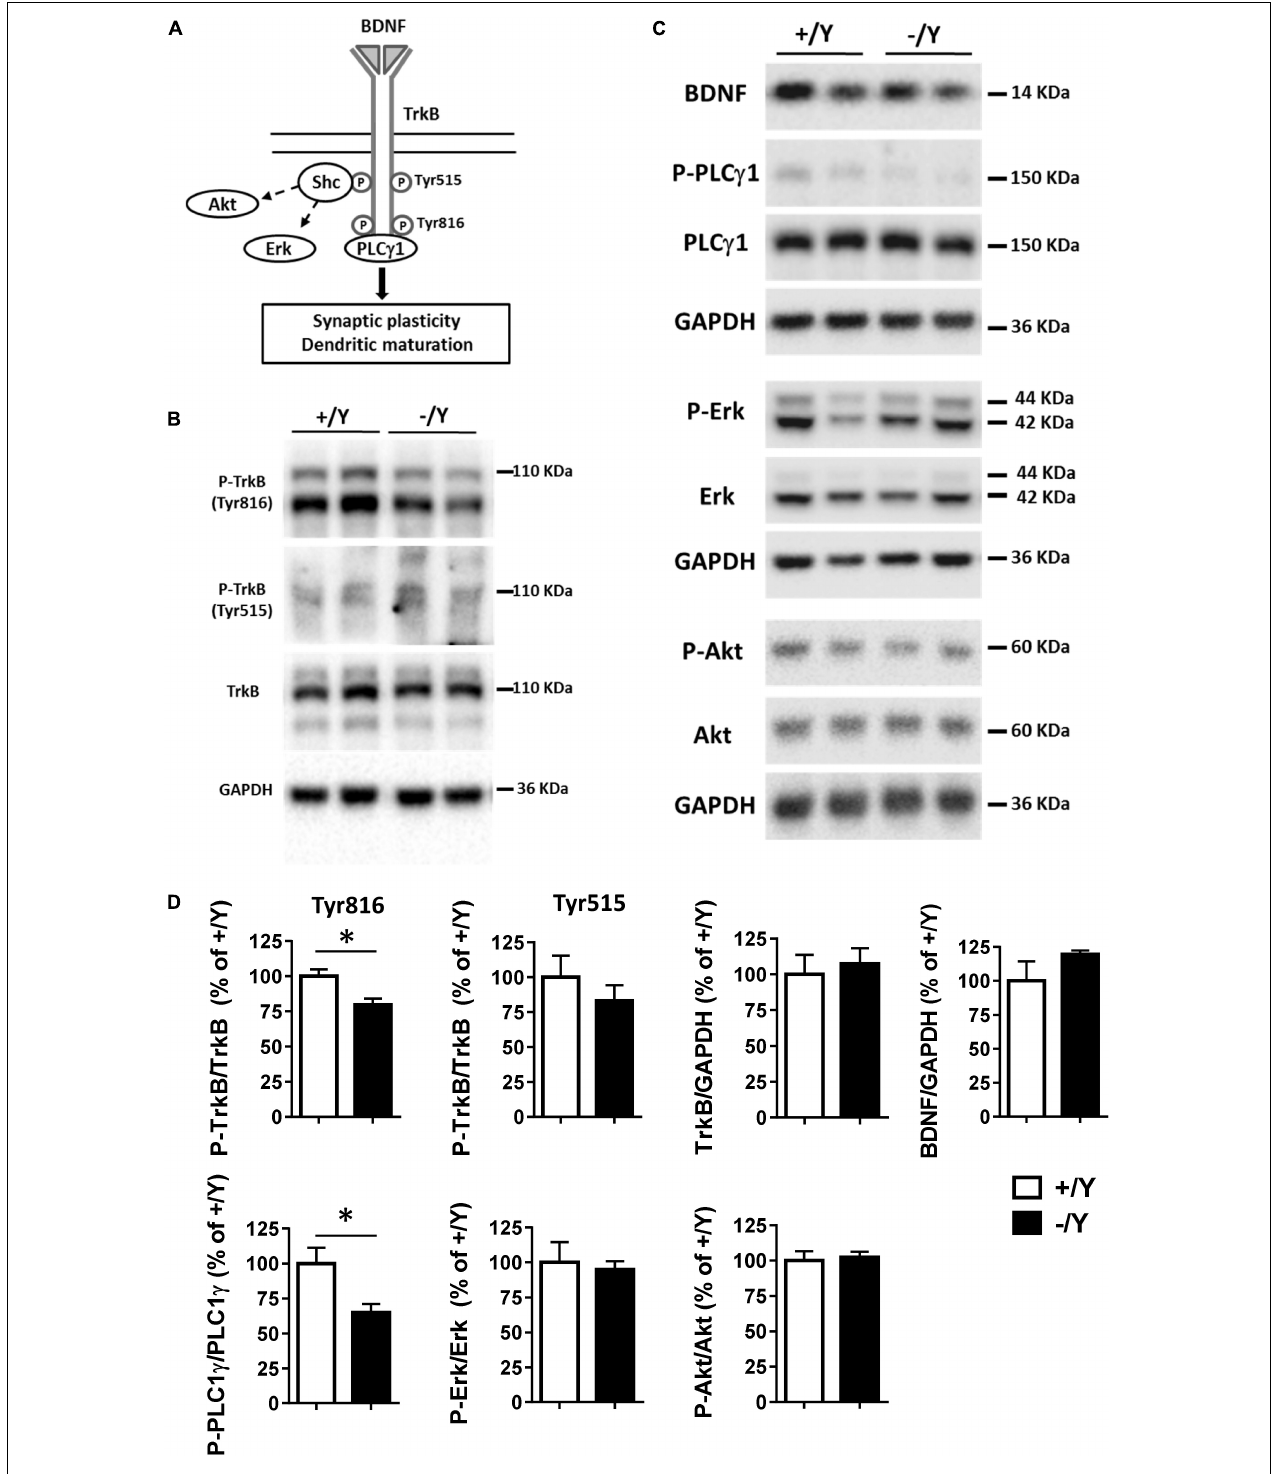
FIGURE 3 | TrkB signaling pathways in the perirhinal cortex of Cdkl5 +/Y and Cdkl5 − /Y mice. (A) Diagram of brain-derived neurotrophic factor (BDNF) and TrkB signaling pathways. BDNF binds to the extra cellular domain of TrkB forming homodimers to activate downstream intracellular signaling cascades, including Shc/Erk, Shc/Akt, and phospholipase C (PLC) γ 1 pathways. (B) Western blots examples of P-TrkB (Tyr816 and Tyr515) and TrkB in PRC homogenates of P50 Cdkl5 +/Y and Cdkl5 − /Y mice. (C) Western blot examples of BDNF, P-PLC γ 1 (Tyr783), PLC γ 1, P-Erk, Erk, P-Akt (Ser437), Akt and GAPDH levels in PRC homogenates of P50 Cdkl5 +/Y and Cdkl5 − /Y mice. (D) The histograms show western blot analysis of samples as in B,C. Phosphoprotein levels were normalized to corresponding